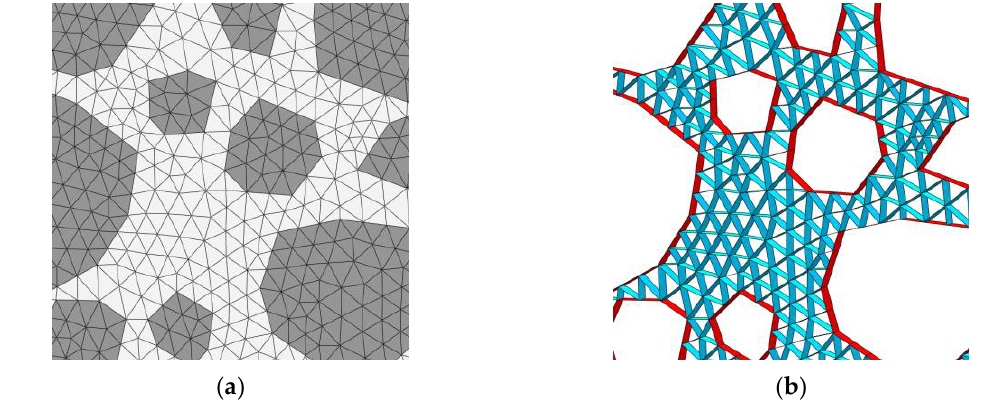
Figure 1. Element mesh of model: ( a ) bulk elements of aggregate (grey colored) and mortar particle (white colored); ( b ) cohesive elements of ITZs (interfacial transitional zones, red colored) and mortar internal interface (blue coloured).